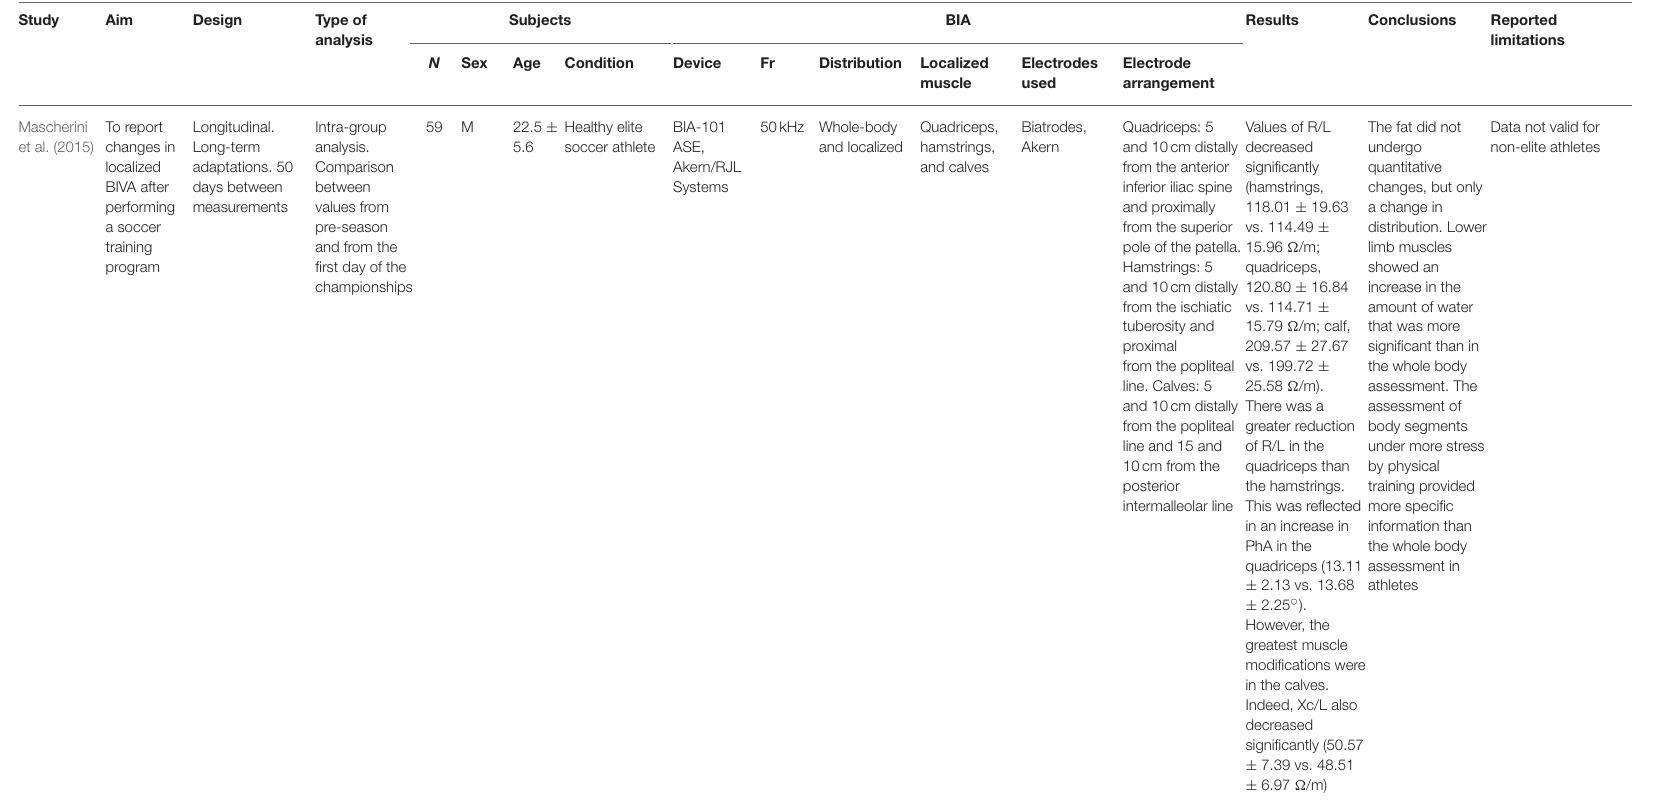
Biatrodes, Akern